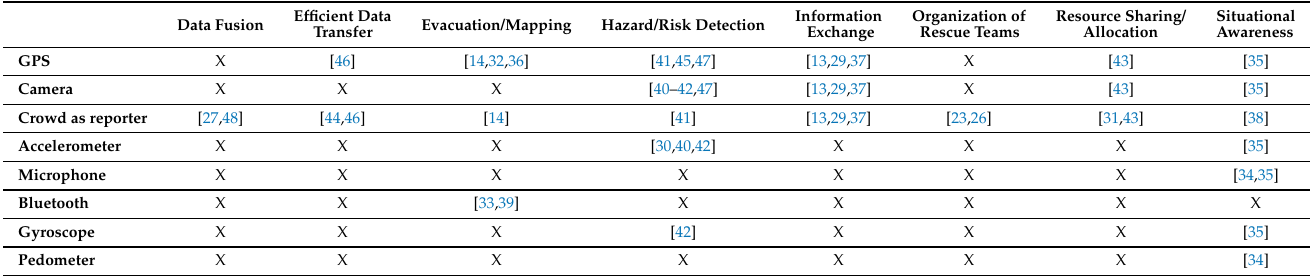
Figure 9. Sensors used in addressing disaster management categories. Table 3. Citations for sensors used in addressing disaster management